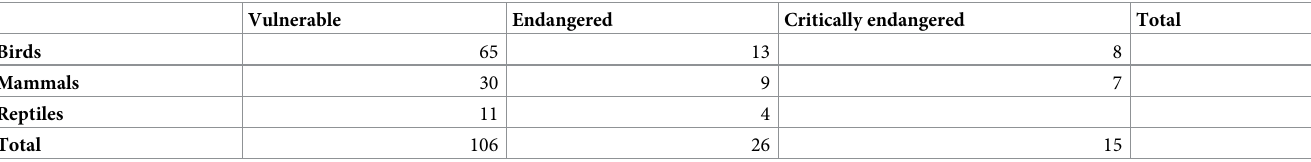
Table 4. Number of New South Wales threatened species reported for each animal group. Vulnerable Endangered Critically